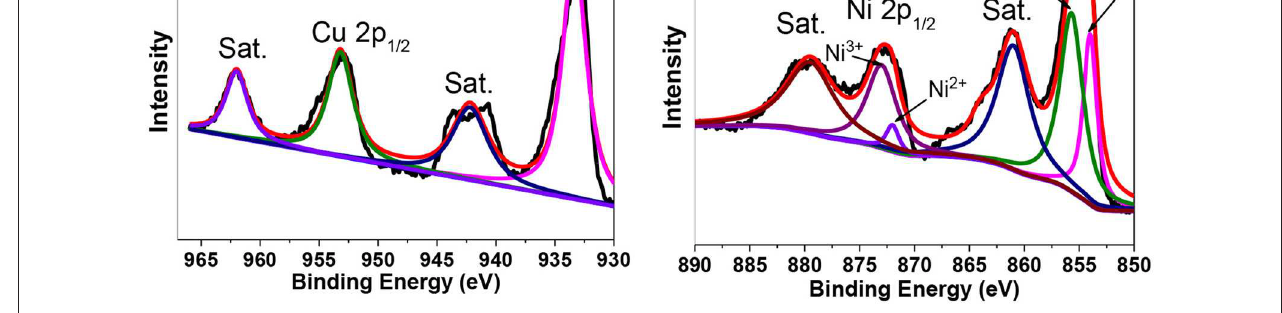
FIGURE 5 | XPS spectra of Cu 2p (A) and Ni 2p (B) .